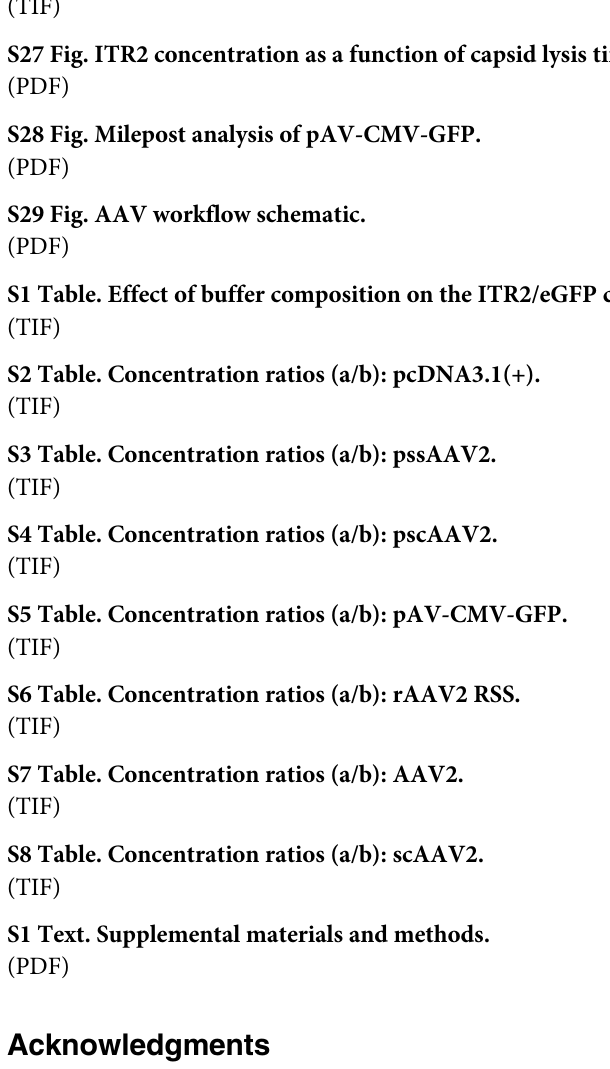
S1 Table. Effect of buffer composition on the ITR2/eGFP concentration ratio. S2 Table. Concentration ratios (a/b): pcDNA3.1(+). S3 Table. Concentration ratios (a/b): pssAAV2. S4 Table. Concentration ratios (a/b): pscAAV2. S5 Table. Concentration ratios (a/b): pAV-CMV-GFP. S6 Table. Concentration ratios (a/b): rAAV2 RSS. S7 Table. Concentration ratios (a/b): AAV2. S8 Table. Concentration ratios (a/b):